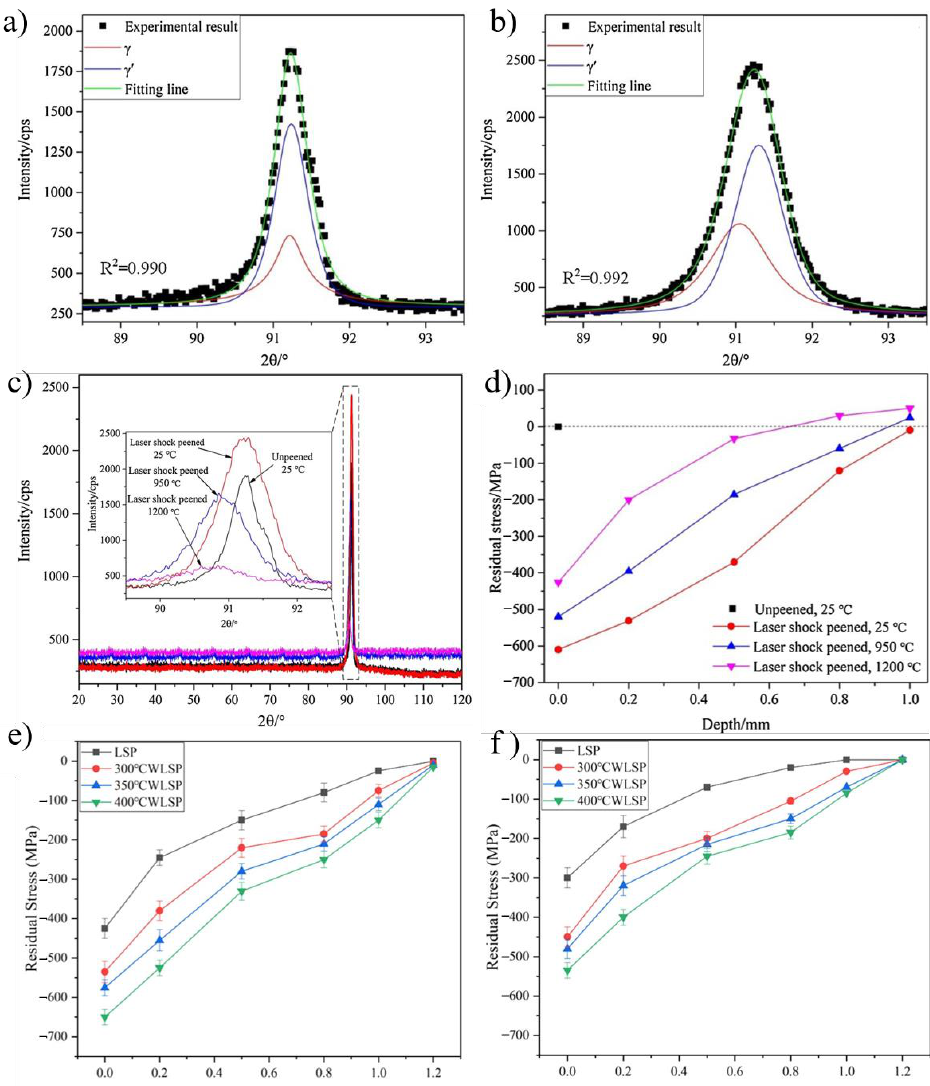
Figure 4. XRD profiles ( a ) before and ( b ) after LP showing a distinct shift in Bragg angle for each respective phase. The overall peak, as well as the sub-peaks for each phase, was fitted with Pseudo- Voight functions. The shifted peak positions collected from LPed specimens subjected to thermal exposure ( c ) and the corresponding residual stress plot is shown in ( d ). Residual stress plots from Tang et al. ( e ) prior and ( f ) following thermal exposure. Reprinted from [45,53] with permission from Elsevier.